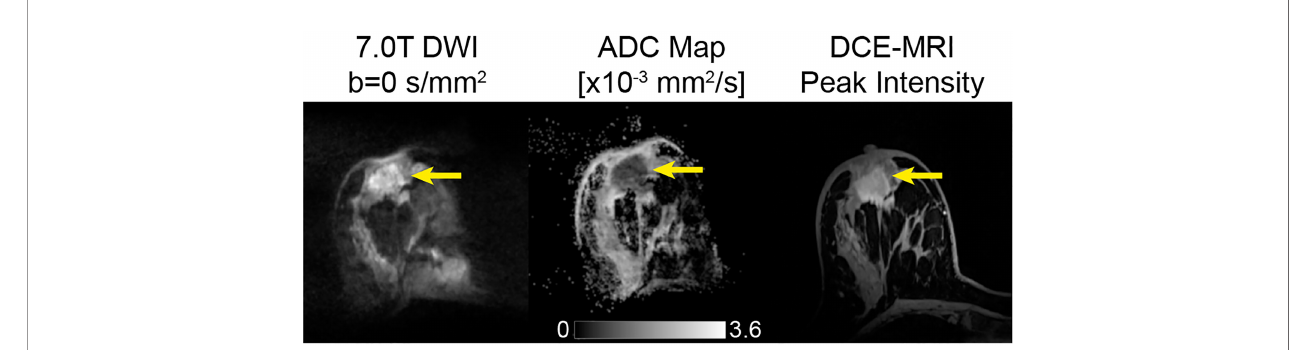
FIGURE 11 | 39-year-old female with invasive ductal carcinoma, imaged at 7T using a dedicated four-channel double-tuned 31 P/ 1 H breast coil. Images shown are b=0 s/mm 2 , corresponding ADC map, and DCE-MRI peak intensity subtraction. The mean ADC of the tumor shown is 0.71 ± 0.18 × 10 – 3 mm 2 /s. For DWI, a transverse DWI read-out segmented echo-planar imaging sequence was used. For DCE, patients were intravenously injected with a single dose of contrast agent (gadoterate meglumine) as a bolus, followed by a 20-mL saline fl ush after three of the 18 repetitions of the time-resolved angiographic imaging with stochastic trajectories sequence (26). (Courtesy of Katja Pinker-Domenig, MD, PhD, Department of Radiology, Memorial Sloan Kettering Cancer Center, New York, New